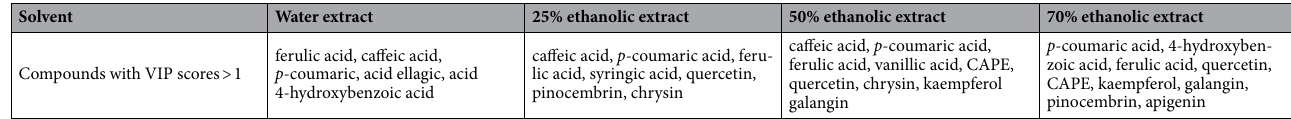
Table 1. Significant chemical compounds in the PLS regression